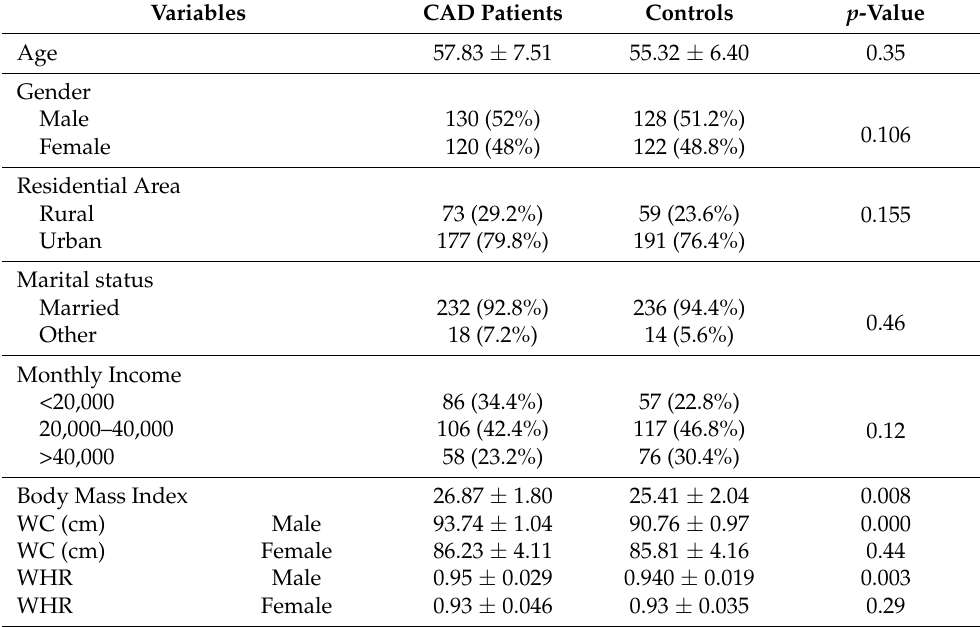
Table 1. Sociodemographic characteristics and anthropometric measurements ( n = 500). Variables CAD Patients Controls p